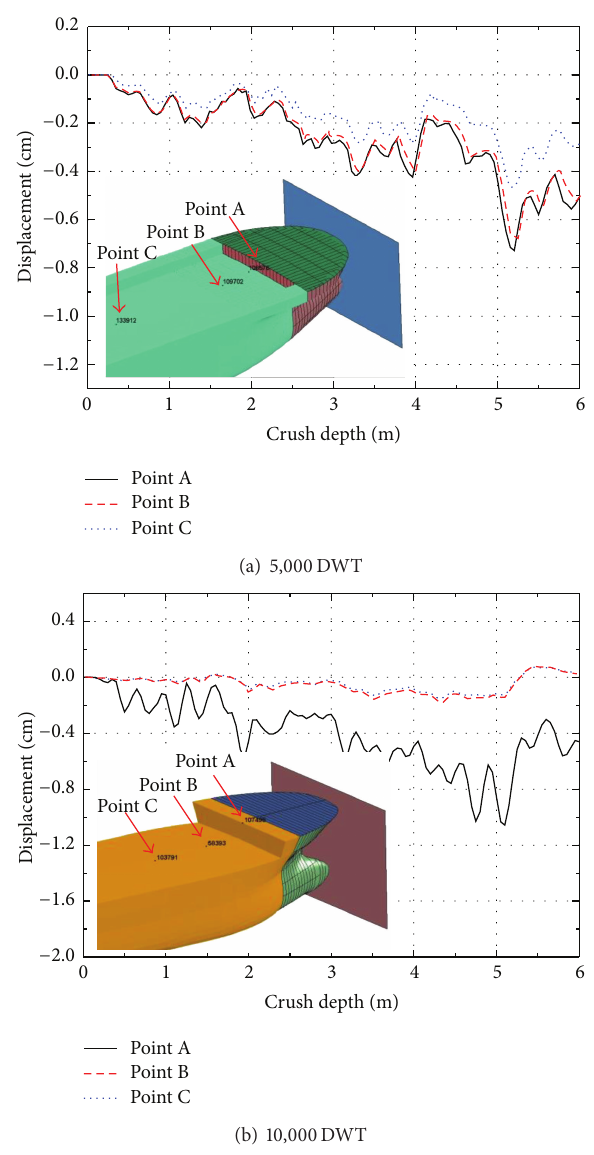
Figure 5: Displacement of the elastic ship hulls in the crush